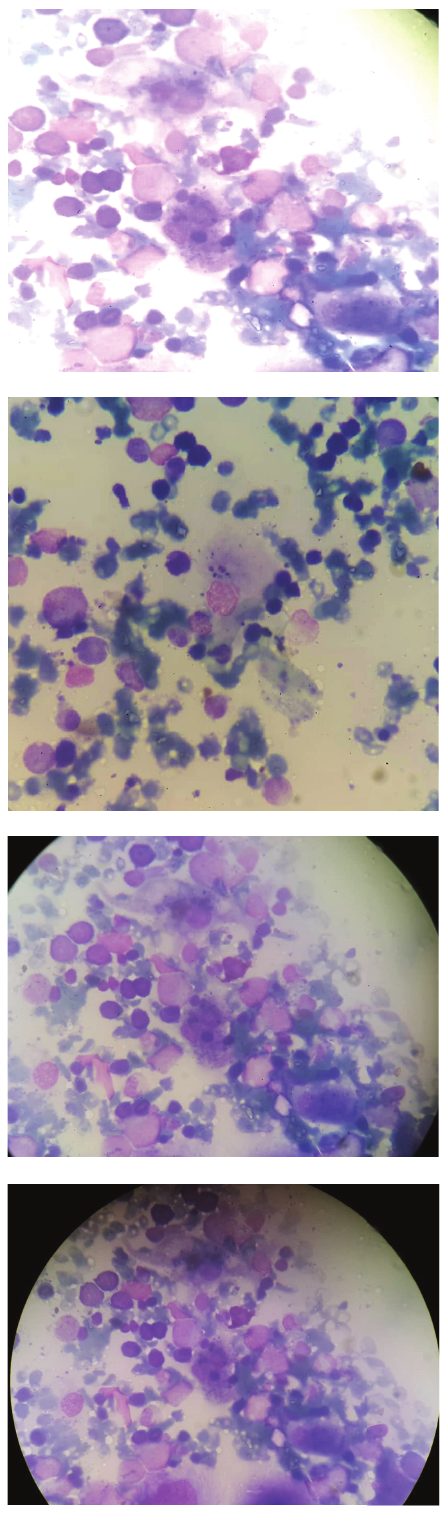
Figure 7: Multiple views of Bone Marrow aspirate showing